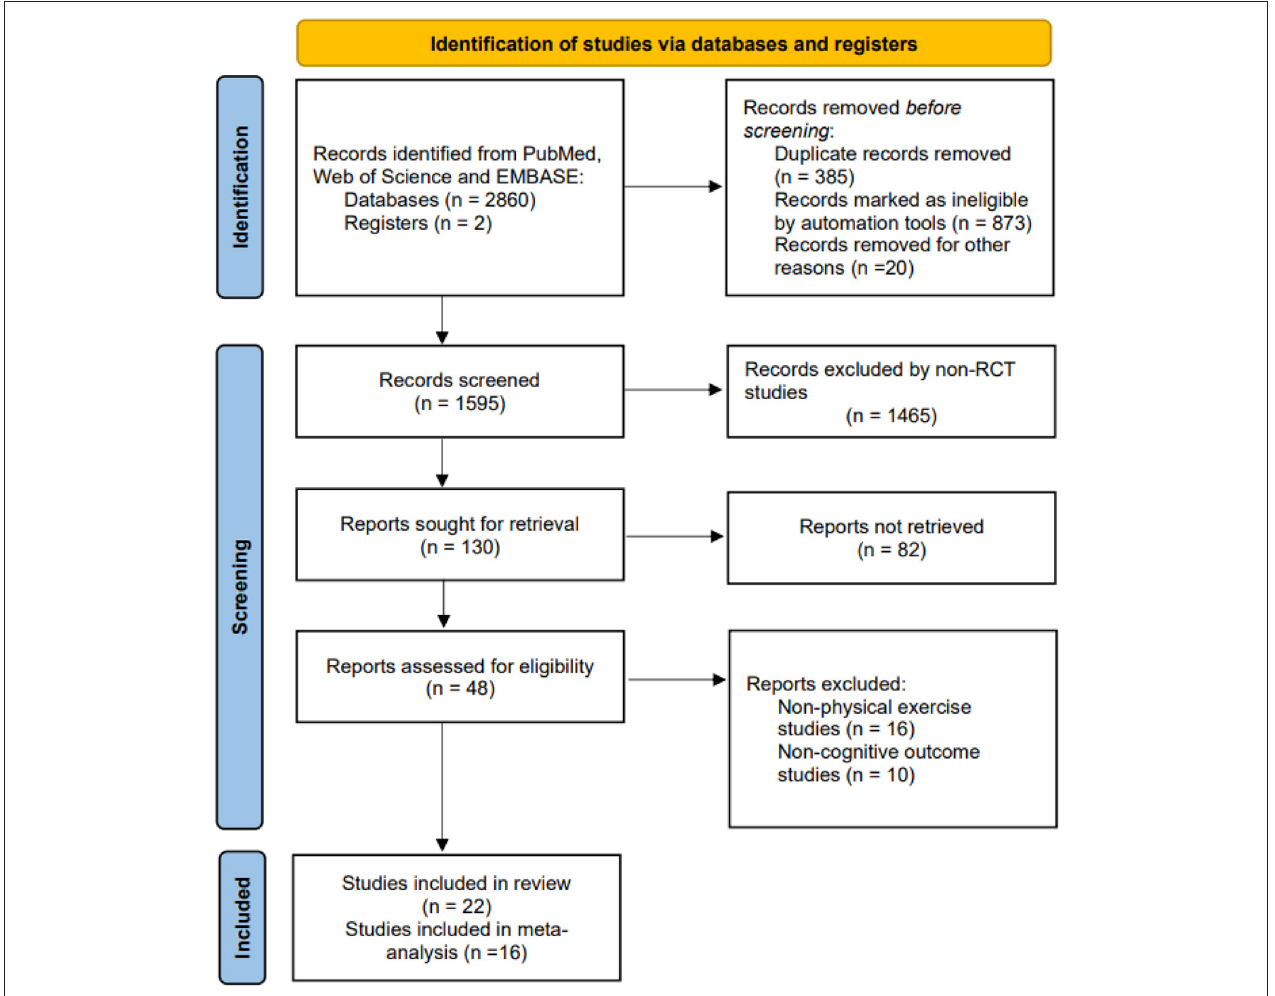
FIGURE 2 | PRISMA flowchart of included and excluded